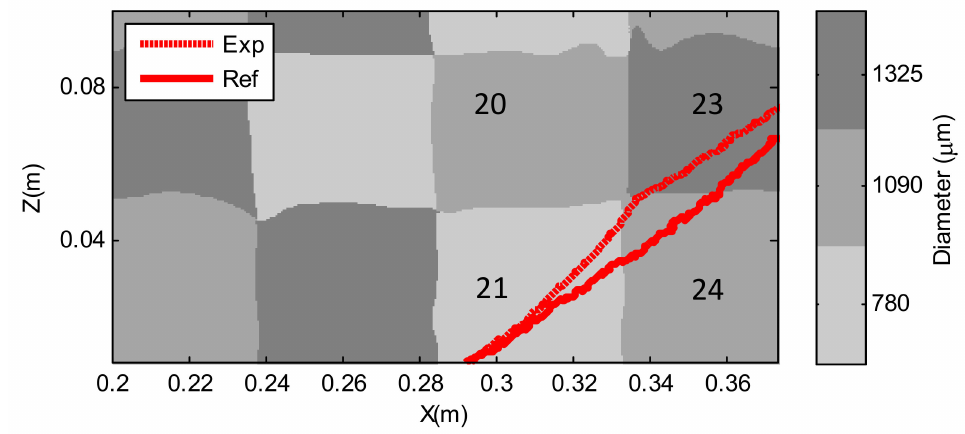
Figure 8. Blocked-1 50% saltwater concentration isolines with labelled permeability zones of interest near the saltwater boundary.